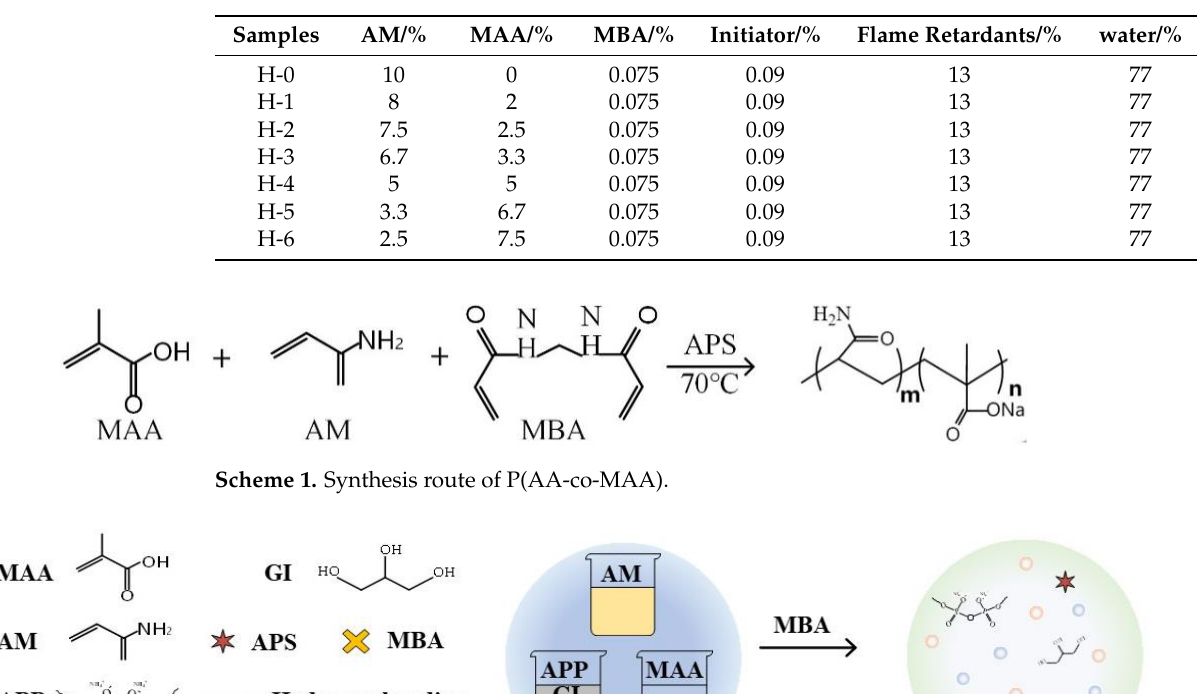
Table 1. Compositions of the transparent flame-retarded hydrogels (mass fraction) %.